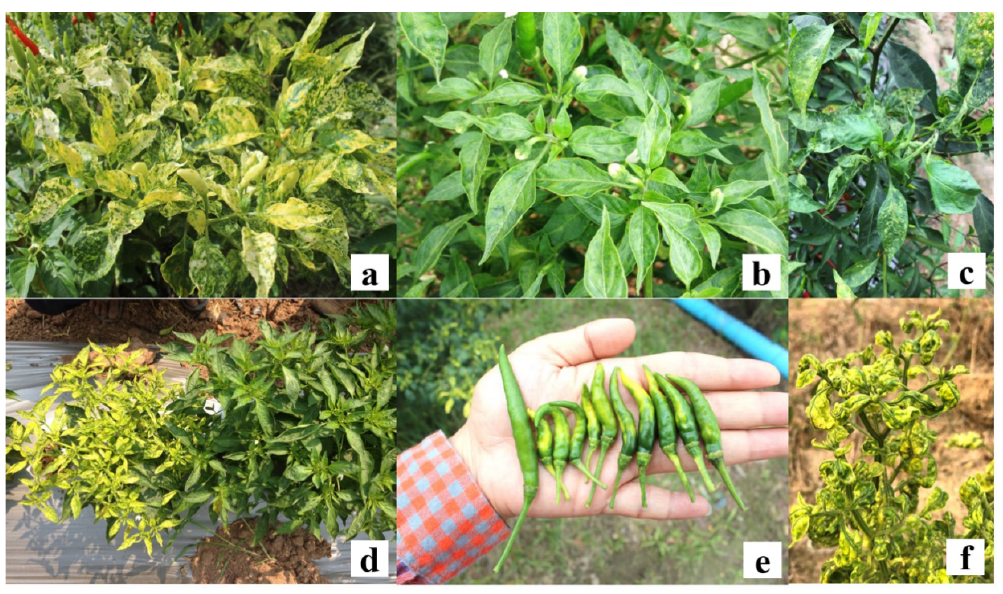
Figure 3: Diseased symptoms of peppers observed in this study . (a) yellow mosaic; (b) green vein mottle; (c) necrotic and ring spot; (d) stunted pepper plant with severe symptom compared with normal plant; (e) yellow mosaic and deformed fruits compared with nomal fruit; (f) yellowing and leaf